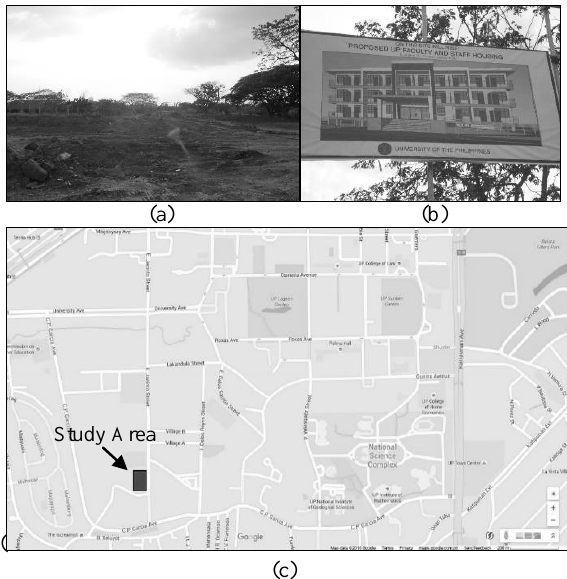
Figure 1. Details of the study area: (a) sample view of the site; (b) site plan proclamation sign; and (c) site vicinity map from Google Maps